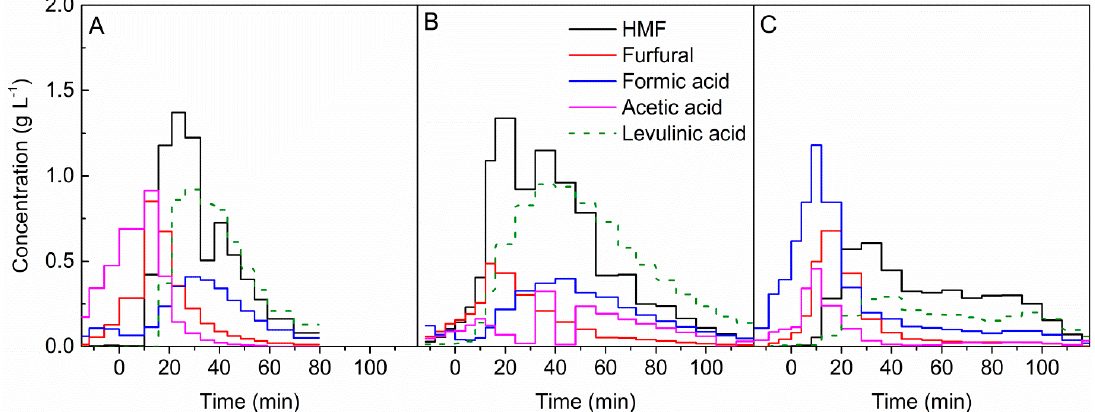
Figure 4. Formation of furfurals and organic acids during the hydrolysis of ( A ) beech wood, ( B ) spruce wood, and ( C ) Miscanthus x giganteus with 0.05 mol L − 1 sulphuric acid at a temperature of 200 °C. t = 0 min marks the beginning of acid hydrolysis.